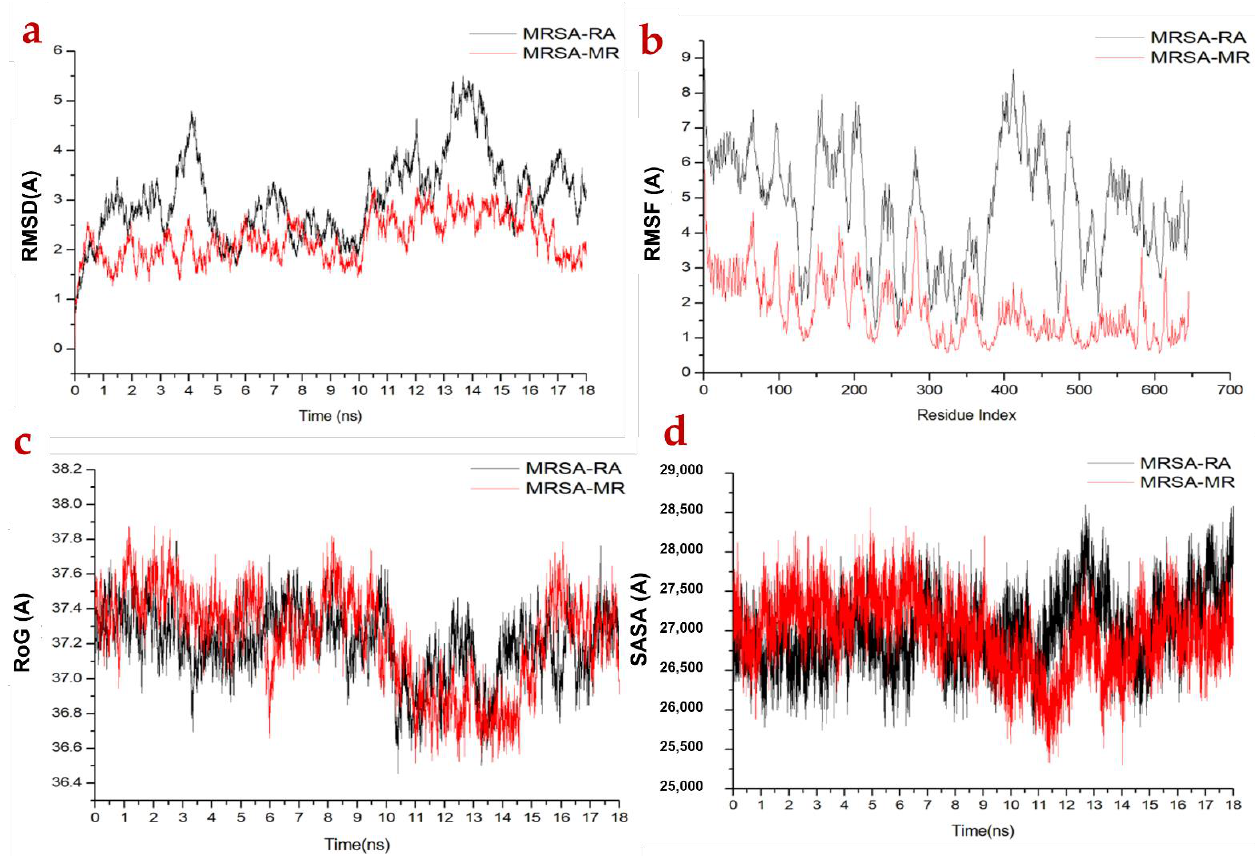
Figure 4 . ( a ) RMSD of Cα atoms of the protein backbone atoms; ( b ) RMSF of each residue of the Figure 4. ( a ) RMSD of C α atoms of the protein backbone atoms; ( b ) RMSF of each residue of the protein backbone Cα atoms; ( c ) ROG of Cα atoms of protein residues; ( d ) solvent accessible surface protein backbone C α atoms; ( c ) ROG of C α atoms of protein residues; ( d ) solvent accessible surface area (SASA) of the backbone atoms relative to the starting. area (SASA) of the backbone atoms relative to the